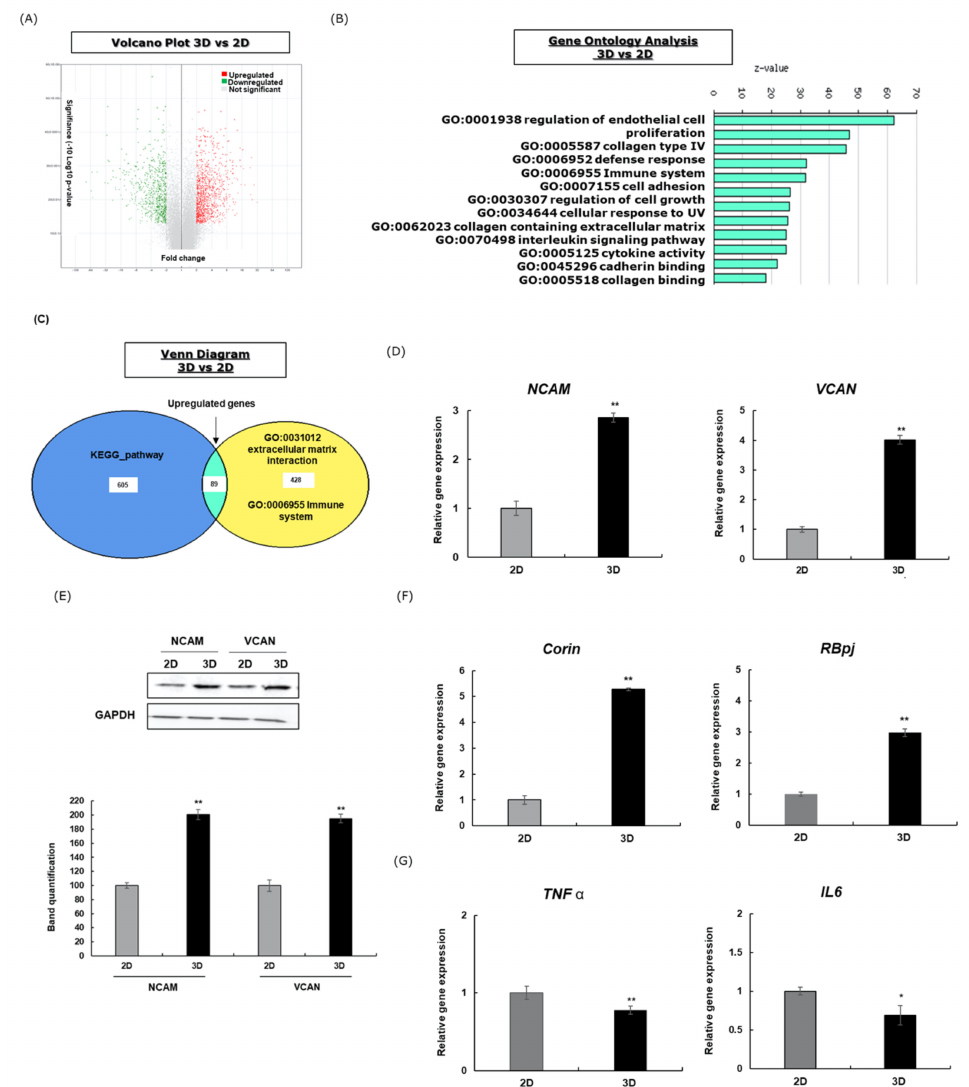
Figure 1. The gene profiling analysis of HFDPCs cultured in 3D spheroids vs. 2D monolayer. ( A ) Volcano plot showing the DEGs. Red, green, and grey illustrate the upregulated, downregulated, and nonsignificant DEGs, respectively. ( B ) The top 12 significantly enriched biological processes by the upregulated DEGs (analysed using Ex atlas). ( C ) Venn diagram showing common and unique sets of DEGs. ( D ) The gene expression of VCAN and NCAM after 48 h. ( E ) VCAN and NCAM protein expression after 48 h. Band intensities were assessed using LICOR. The results represent the mean ± SD of three independent experiments. * p ≤ 0.05, ** p ≤ 0.01. ( F ) The gene expression of DPC marker CORIN and, Notch pathway effector RBbj after 48 h. ( G ) Gene expression of inflammation associated genes after 48 h. The mRNA level was quantified using TaqMan real-time